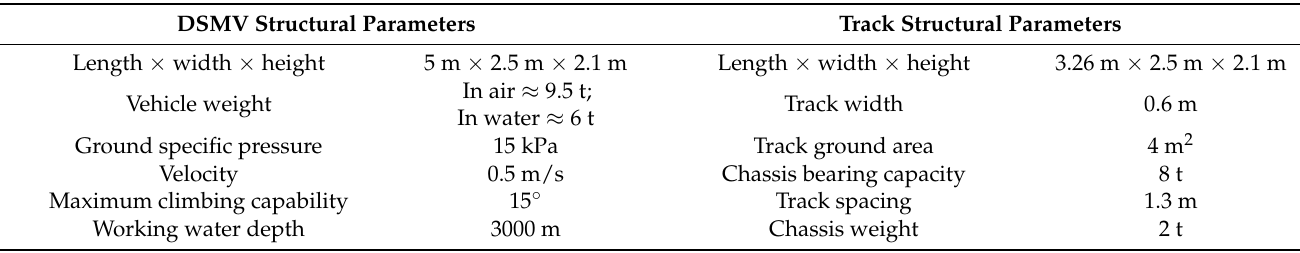
Table 2. DSMV and track structural